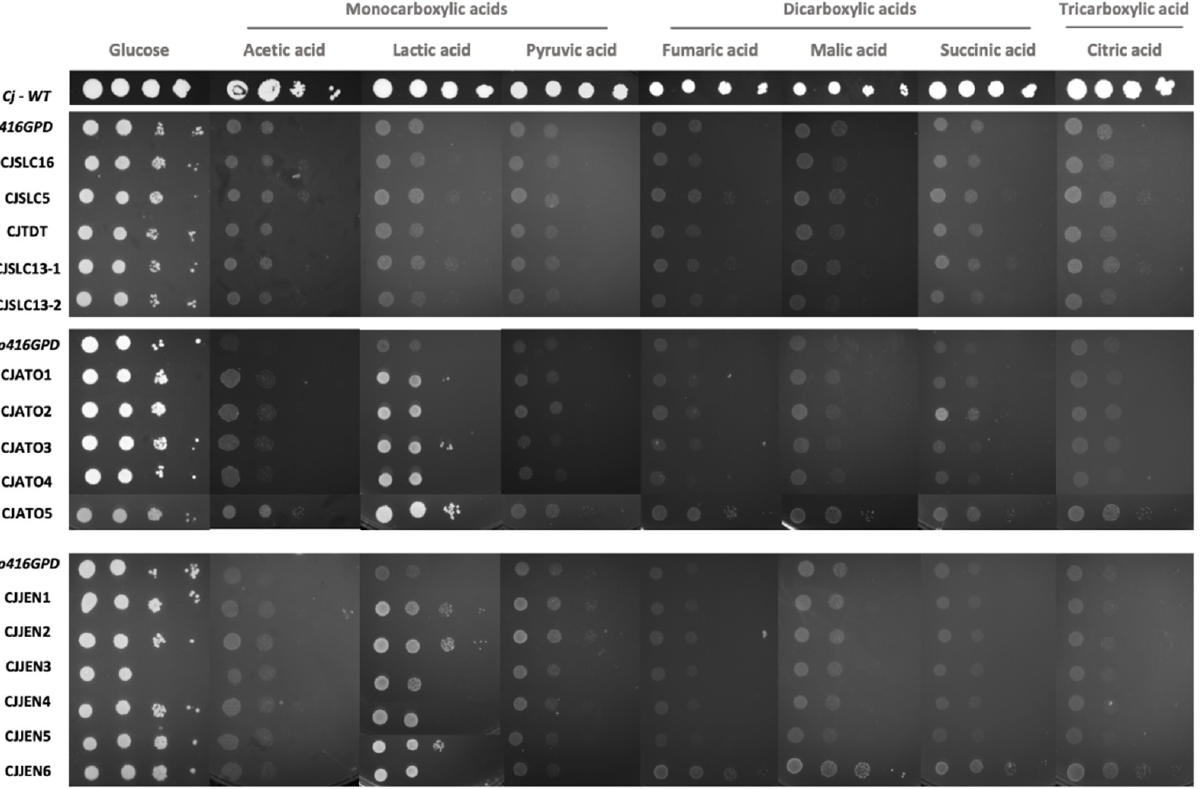
Figure 2. Functional analysis of sixteen C. jadinii carboxylate transporters in S. cerevisiae IMX1000